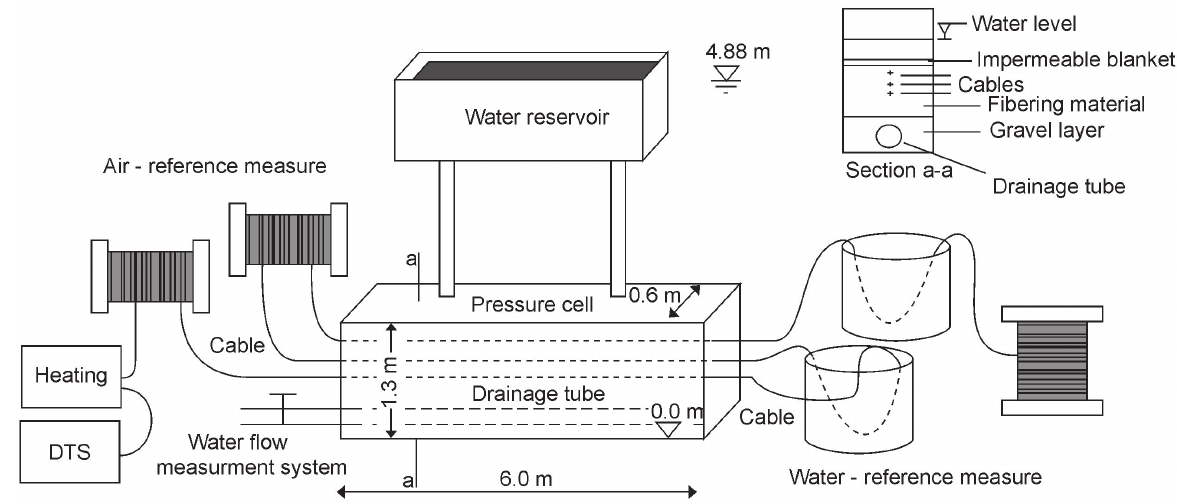
Figure 2 - Schematic of the